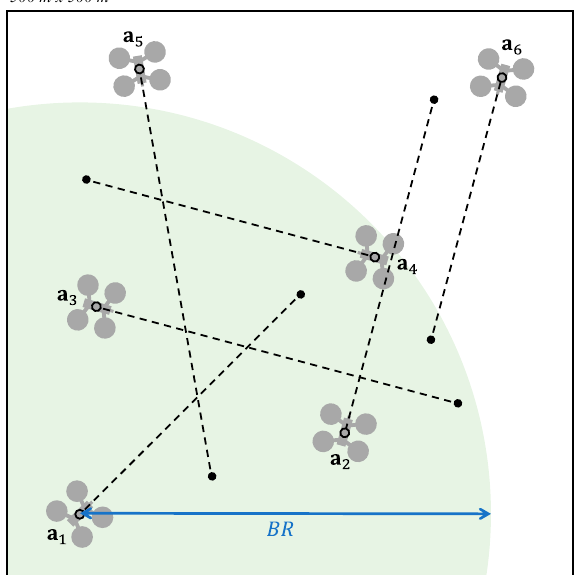
Figure 5. Airspace bounding for 𝐚 (cid:2869) .